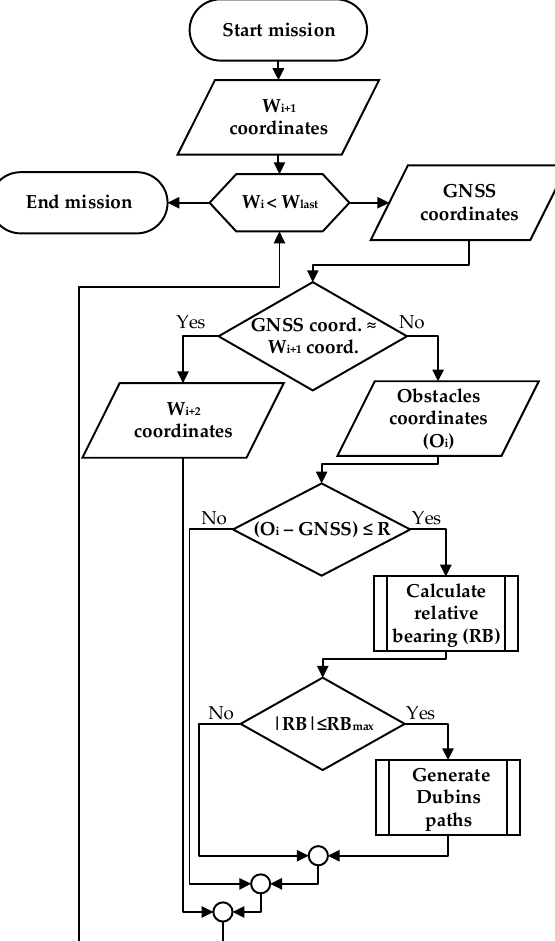
Figure 6. Algorithm for UAV ground obstacle avoidance.